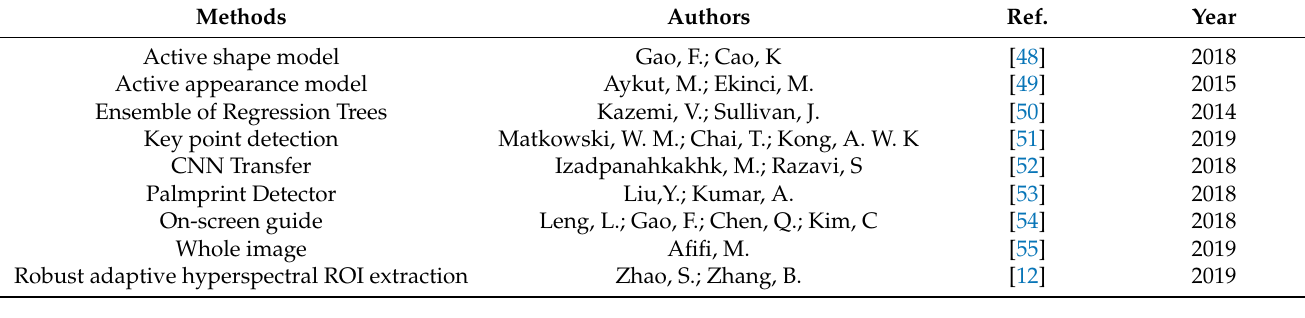
Table 2. Overview of palmprint ROI extraction methods.